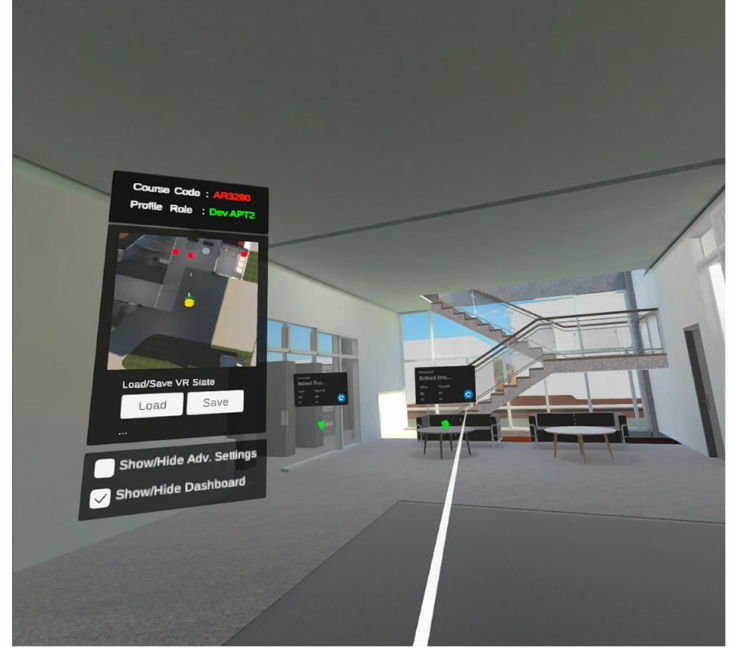
Figure 2. VRDR was built using the Unity game